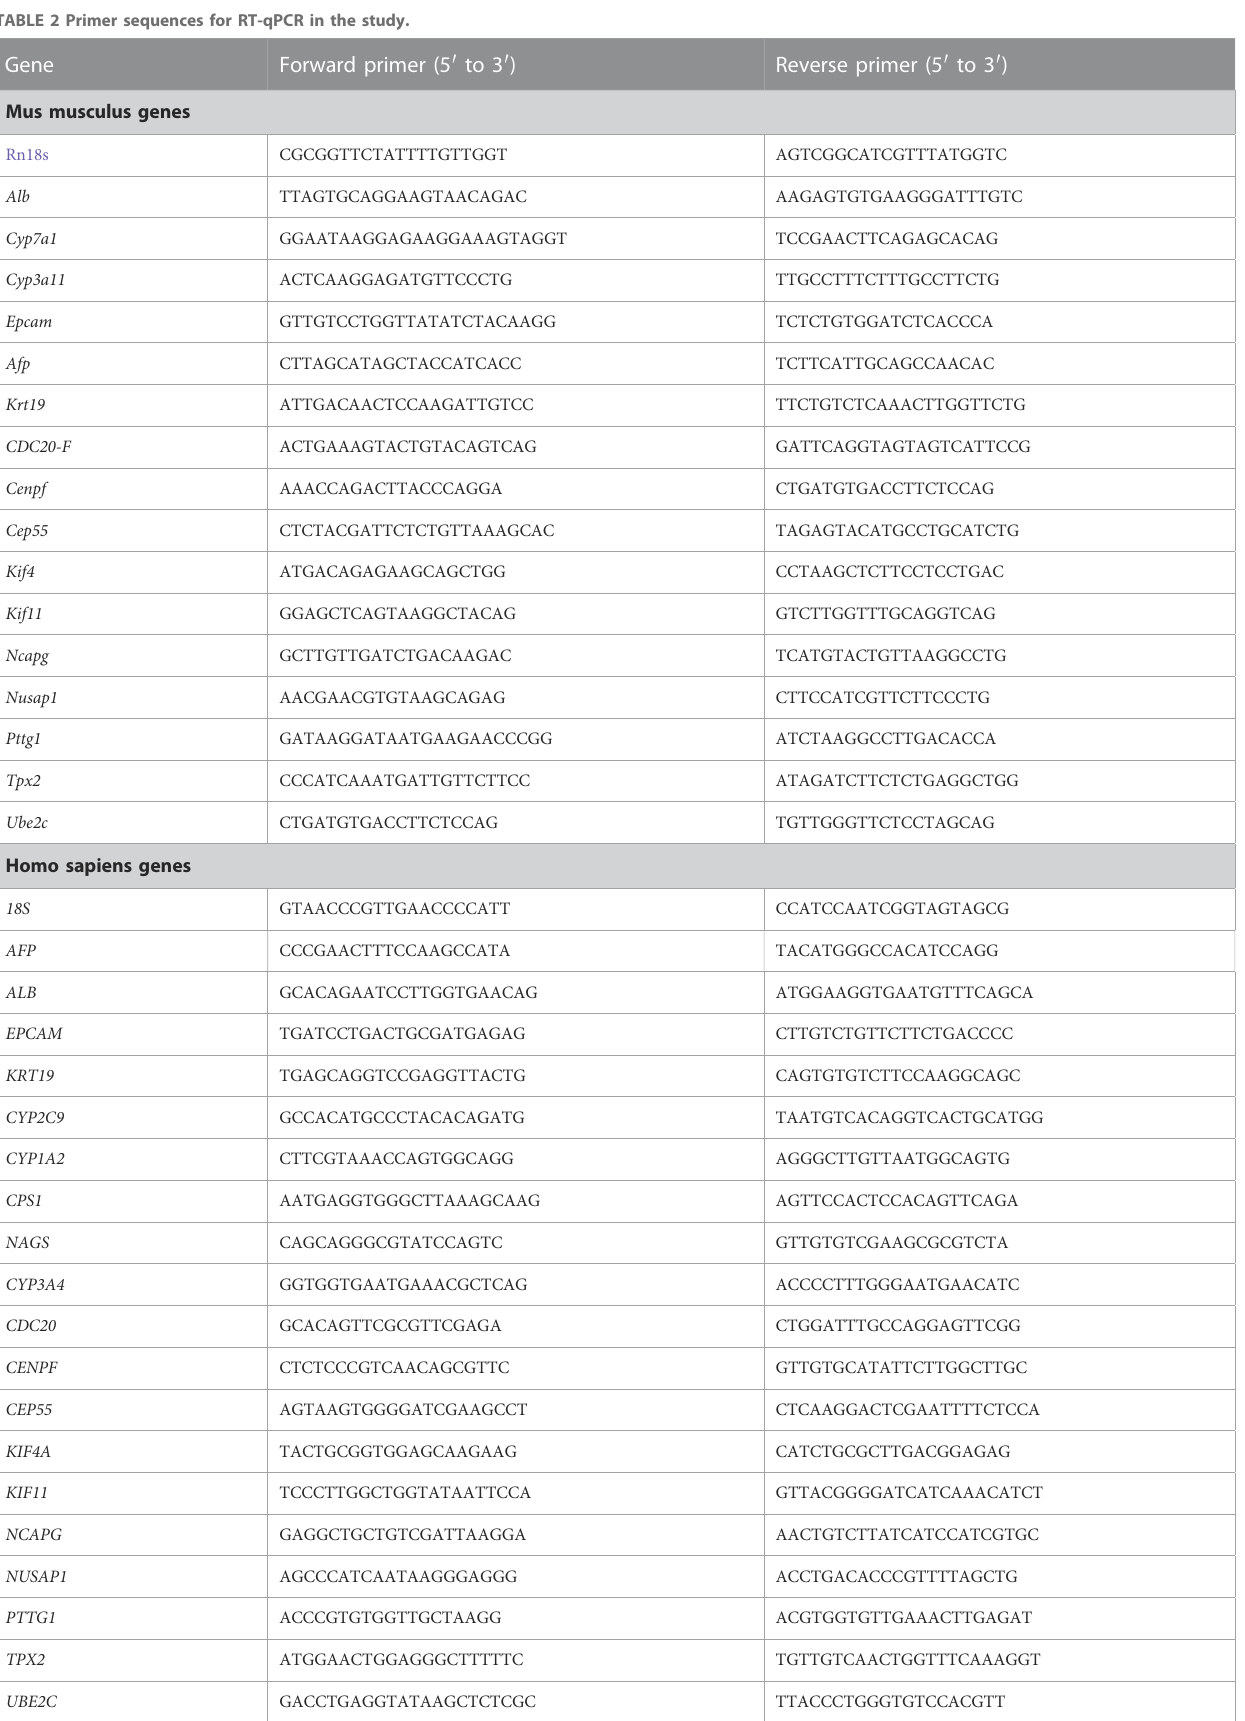
TABLE 2 Primer sequences for RT-qPCR in the study. Gene Forward primer (5 ′ to 3 ′ ) Reverse primer (5 ′ to 3 ′